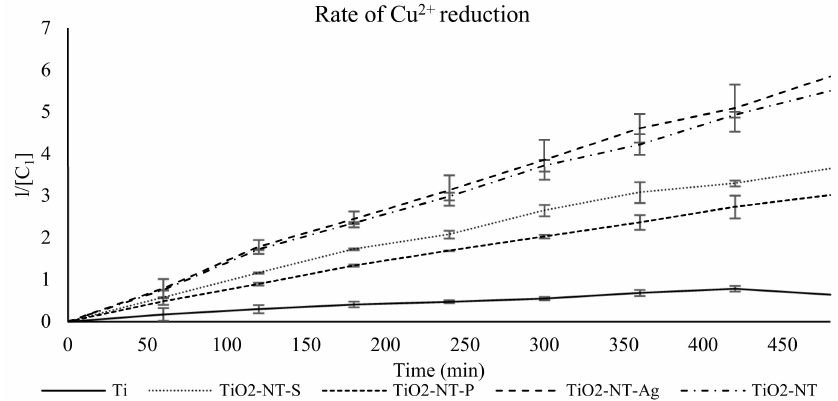
Figure 5. Rate of reaction for the reduction of Cu 2 + to Cu + in the presence of neocuproine and di ff erent TiO 2 surfaces after exposure to UV at 10 mWcm − 2